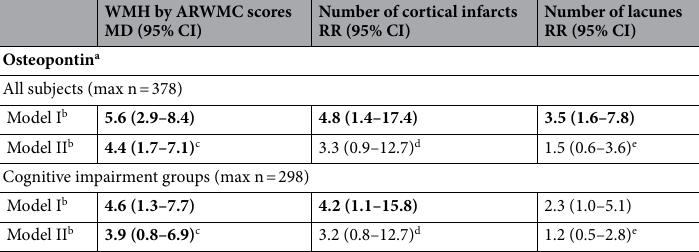
Table 4. Association between osteopontin and markers of cerebrovascular disease (CeVD), expressed in risk ratios (RR) or mean differences (MD) and the respective 95% confidence interval (CI). Bold values indicates p < 0.05 using Poisson or linear regression. CeVD, cerebrovascular disease; WMH, white matter hyperintensities; ARWMC, age-related white matter changes; max n, maximum number; RR, risk ratio; MD, mean difference; CI, confidence interval. a Log-transformed. b Adjusted for age, gender, APOE ε4 carrier, hypertension, hyperlipidemia, cardiovascular disease, and additionally for c cortical infarct and lacunes, d WMH and lacunes, or e WMH and cortical infarct.